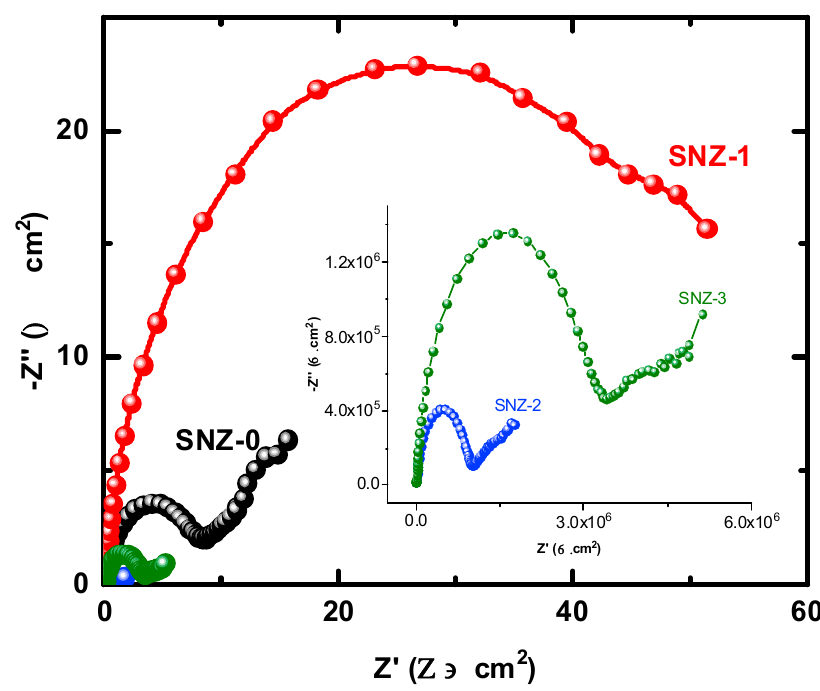
Figure 10. Nyquist plots of the coatings after 30 days’ immersion in a 3.5% NaCl solution.